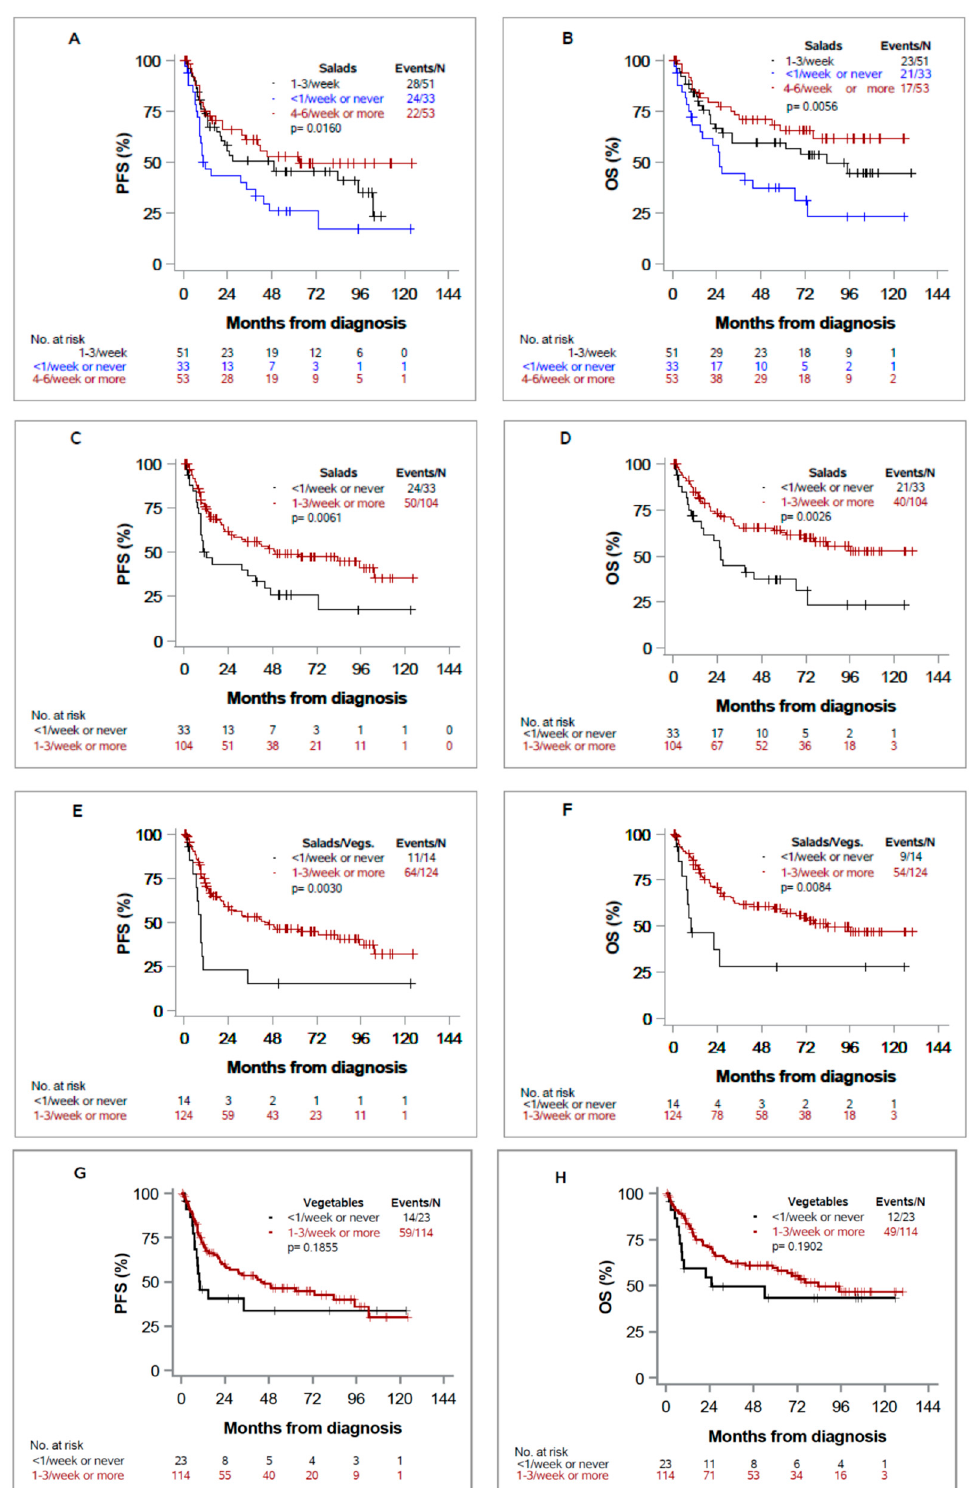
Figure 1. Kaplan–Meier curves for progression-free survival (PFS) and overall survival (OS) in head and neck cancer cases by intake of “salad” (plots A – D ), intake of “salad or other vegetables” (plots E , F ), and intake of other vegetables (plots G , H ). Vertical tick marks indicate censored obser- vations.